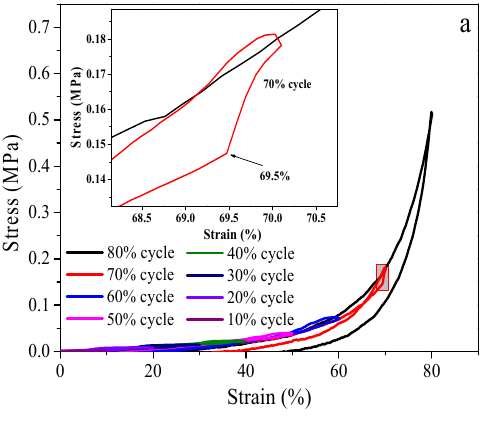
Figure 5. Effect of solid content on compression properties of p–DN hydrogel.